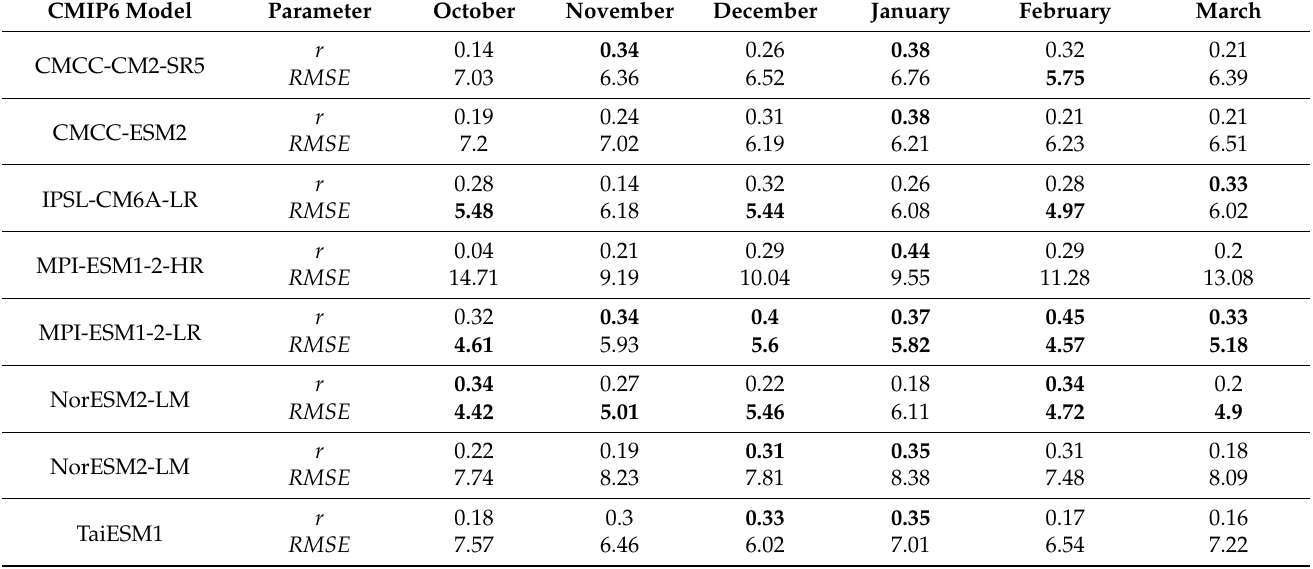
Table 2. Spatial linear correlation coefficient ( r ) and root mean square error ( RMSE ) between the fre- quency of cyclones over the North Atlantic–European sector in the CMIP6 models and NCEP/NCAR reanalysis in the period from 2000 to 2014. The highest (for r ) and lowest (for RMSE ) 30% val- ues of the entire range of the comparison parameters (for both reanalyses and all 12 months) are marked in